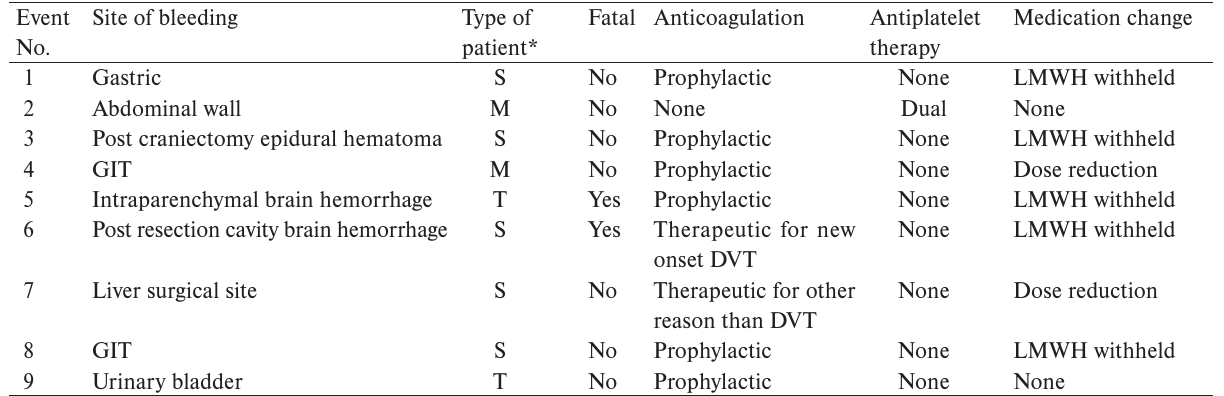
Table 4. Major bleeding